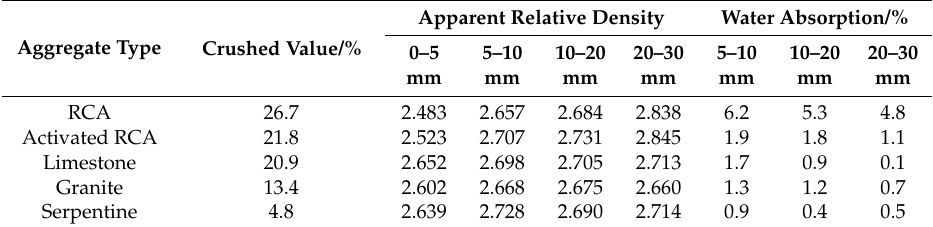
Table 2. Technique performance of aggregates.